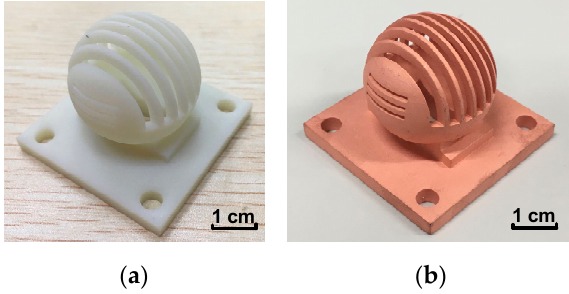
Figure 9. Photographs of the fabricated SWA: ( a ) the three-dimensional (3D) printed prototype before surface metallization; ( b ) the copper-plated antenna.